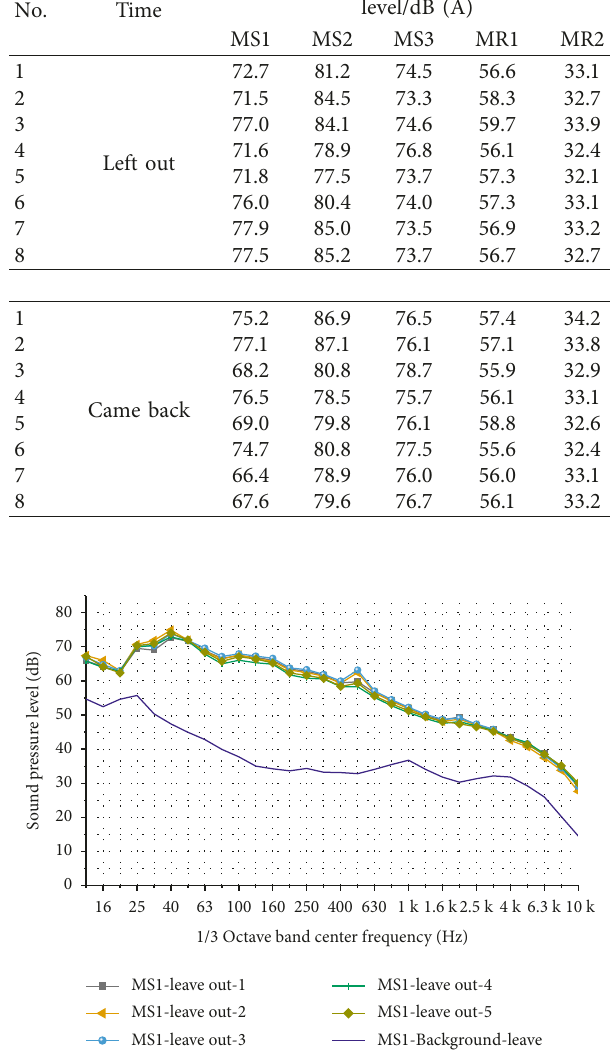
Figure 9: 1/3 octave frequency spectrum for measurement points MS1.